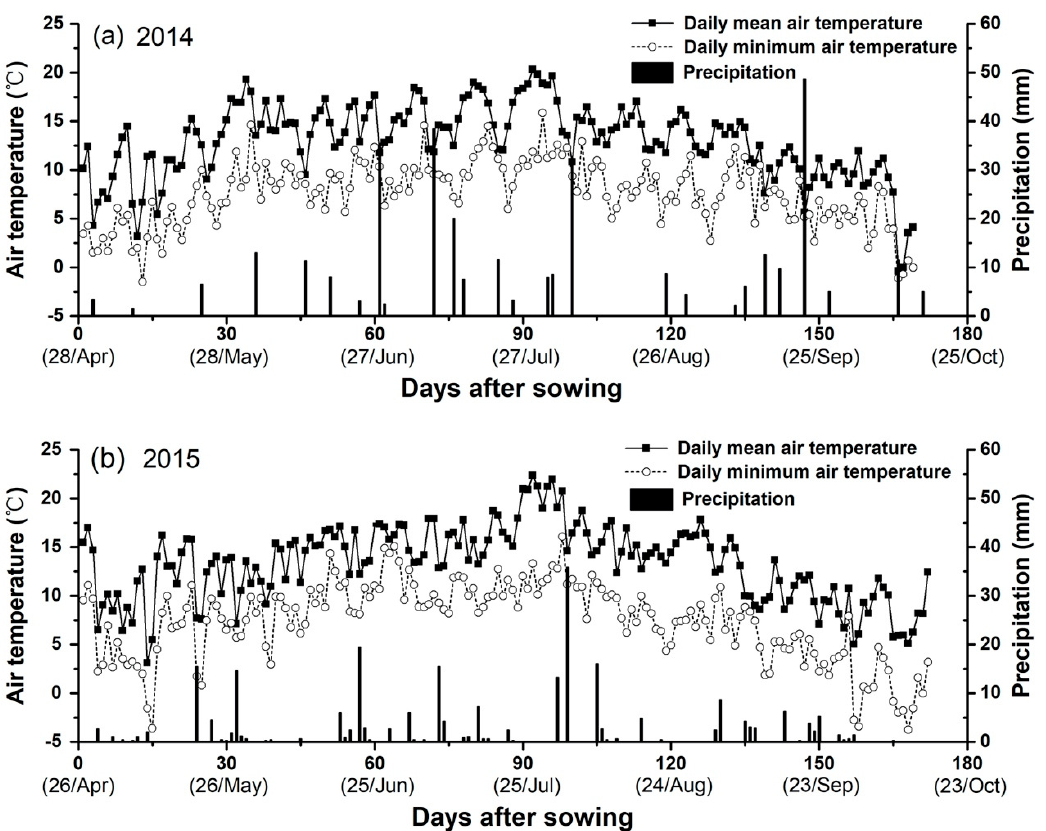
Figure 1. Precipitation, daily mean air temperature, and daily minimum air temperature during the growth period of corn in ( a ) 2014 and ( b ) growth period of corn in ( a ) 2014 and ( b ) 2015.